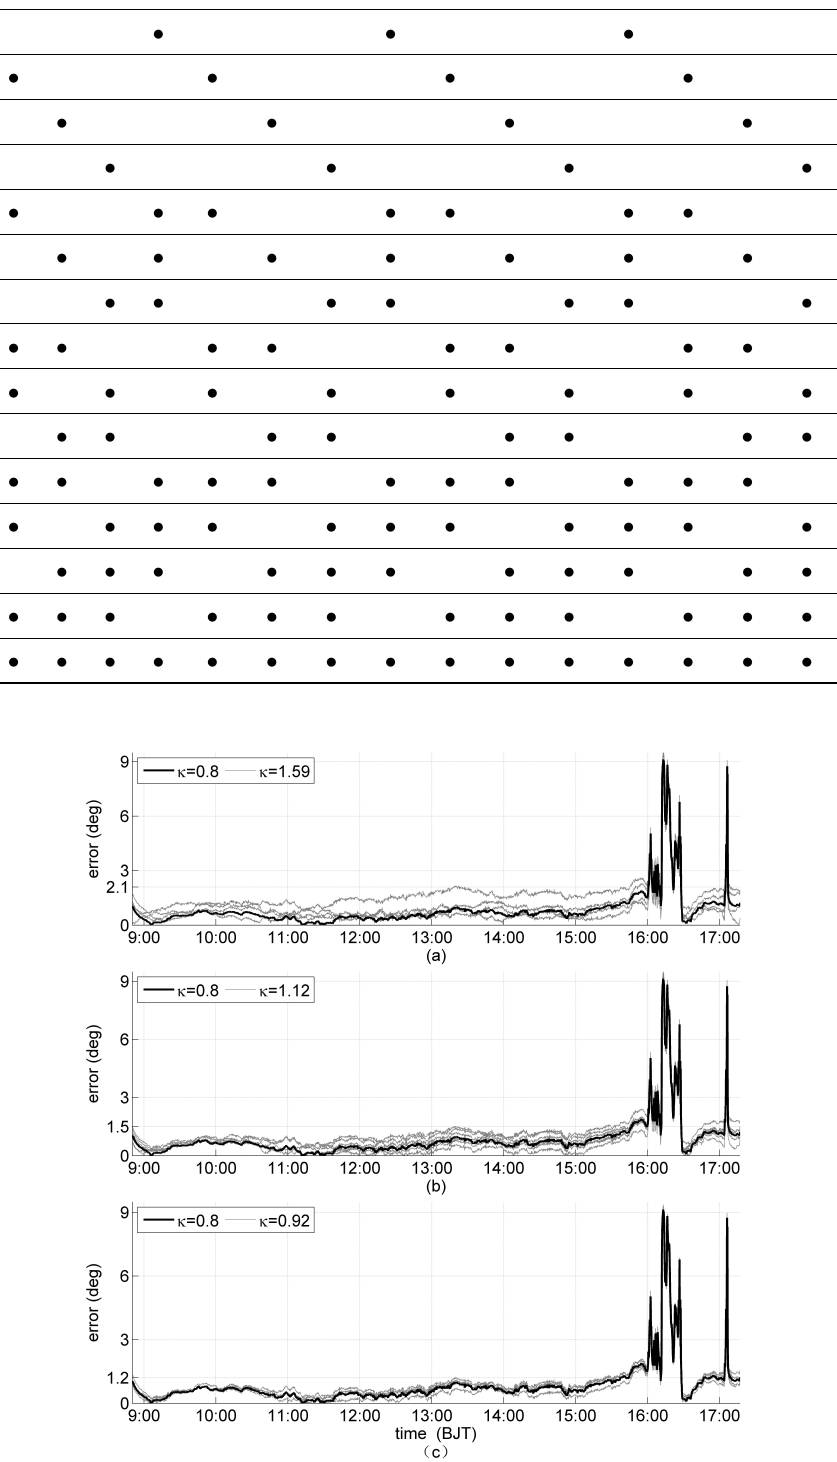
Figure 8. Orientation error for orientation matrices with the same κ a but different κ values: κ = 1.59, 1.12, and 0.92 shown as thin gray lines in ( a – c ); and κ = 0.8 as thick black line in all